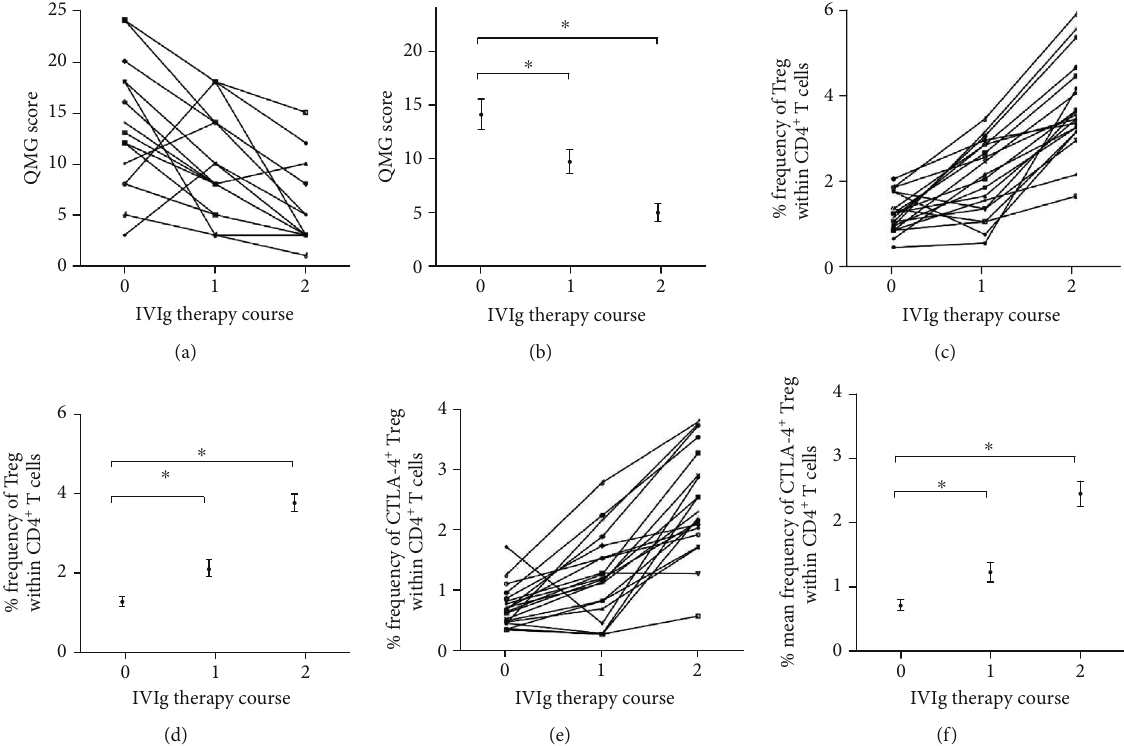
Figure 3: Dynamic changes of regulatory CD4 + T cells in MG patients and their QMG scores during IVIg therapy demonstrated a positive correlation between IVIg therapeutic e ff ect and frequency of Tregs and CTLA-4 + Tregs. The individual (a) and mean (b) QMG scores were determined for MG patients ( n = 20 ) during the two courses of IVIg therapy. The individual and mean frequency of CD4 + CD25 + FOXP3 + Treg cells (c, d) and CD4 + CD25 + FOXP3 + CTLA-4 + Treg cells (e, f) were measured by FACS analysis of PBMCs from IVIg-treated MG patients ( n = 20